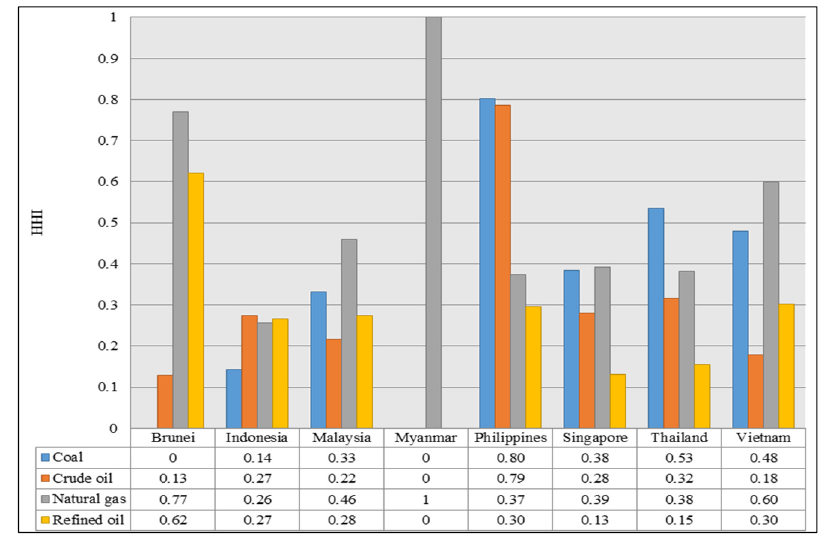
Figure 46. Market concentration of energy